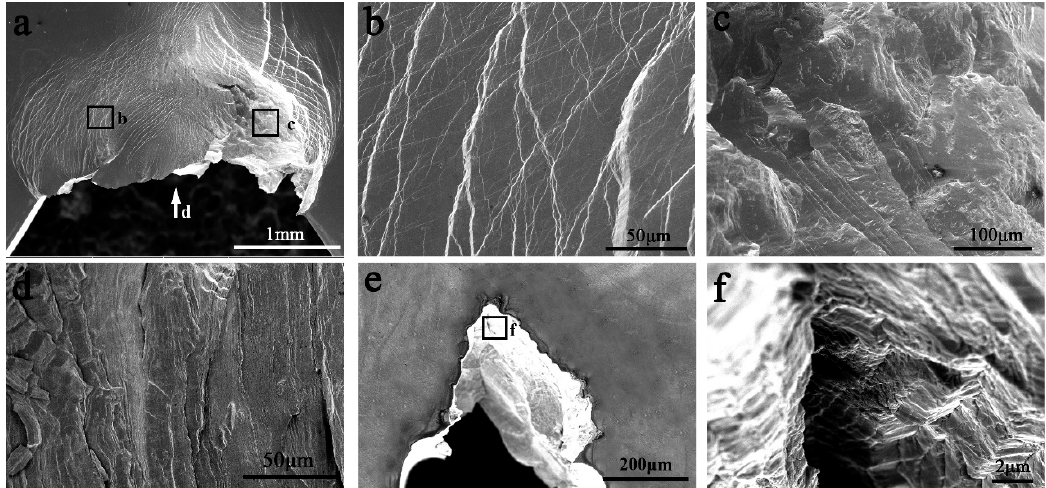
Figure 4. Appearance of a Pd 77.5 Cu 6 Si 16.5 MG sample with a size of 2.2 × 3.8 × 25 mm 3 after 3-point bending. ( a – c ) Side surface appearance. ( d – f ) Fracture surface appearance.